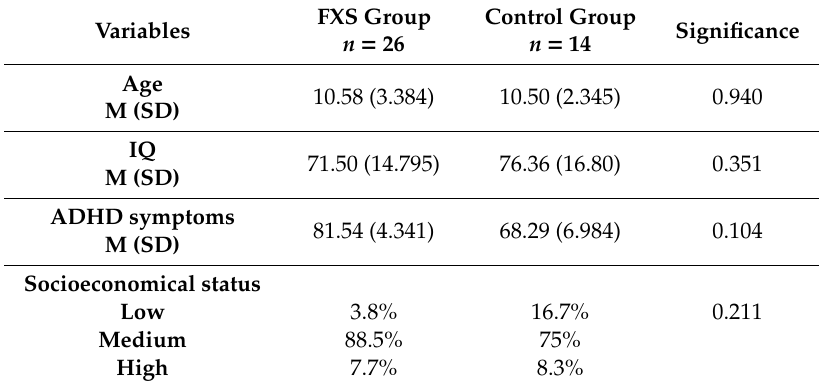
Table 1. Descriptive measures and distribution of age, IQ, ADHD Symptoms, and socioeconomical status.